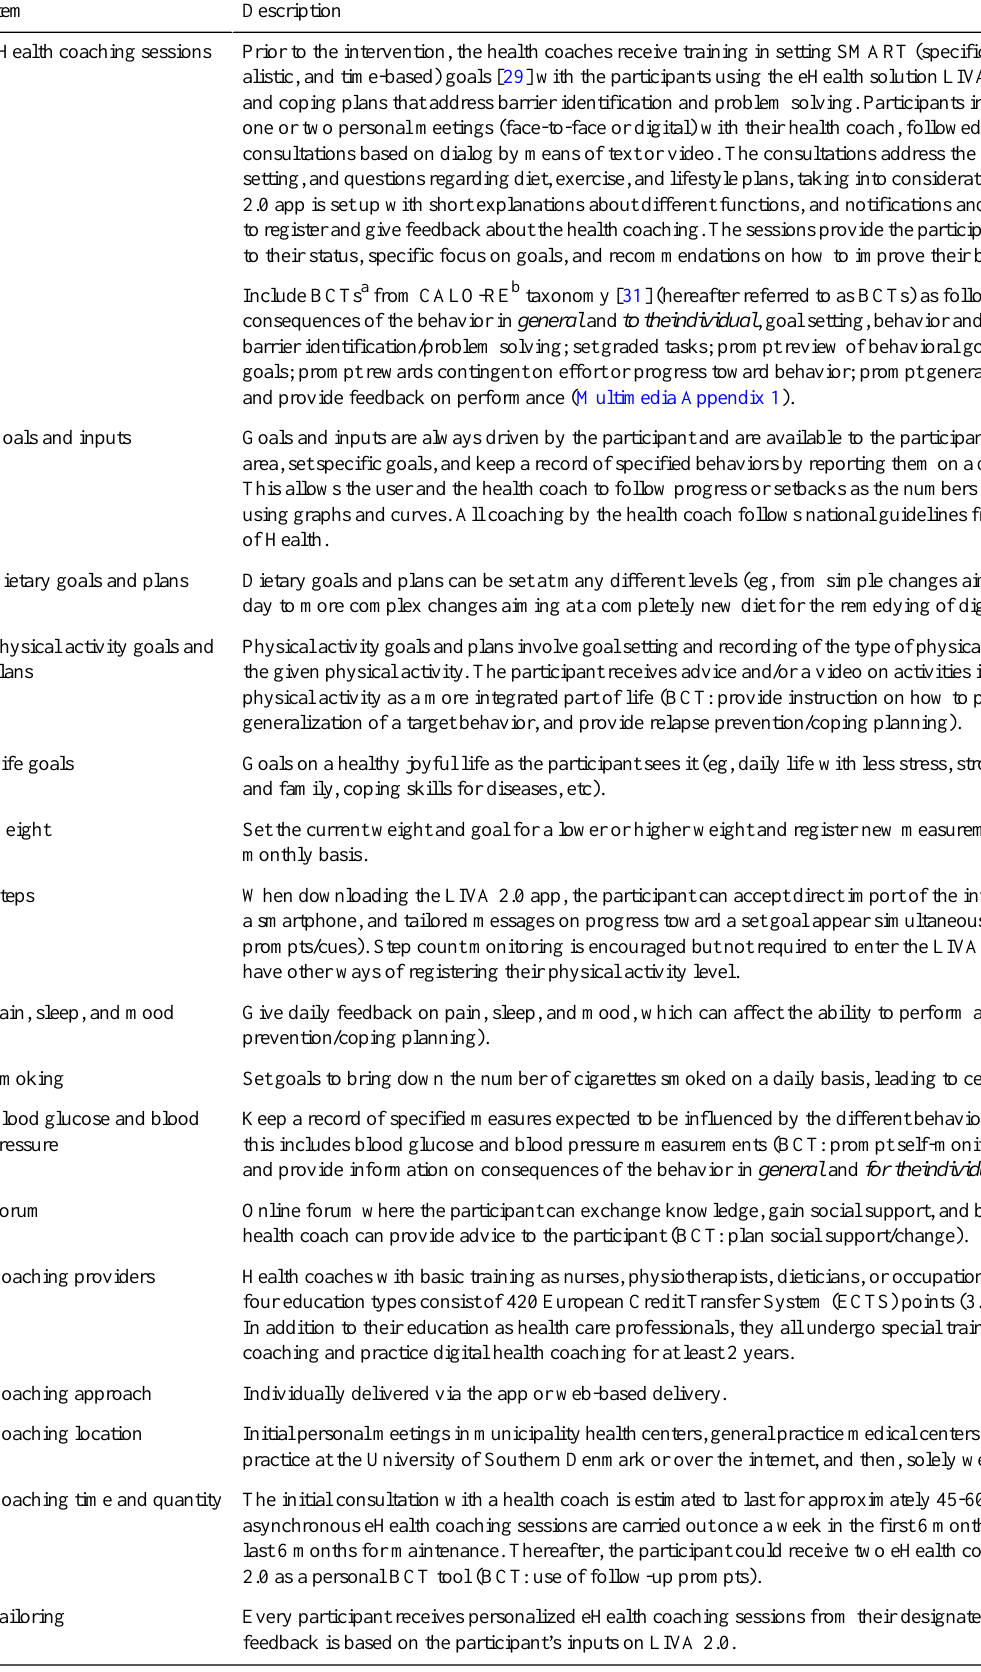
Table 1. Template of the Intervention Description and Replication checklist [30] for the eHealth lifestyle coaching tool (LIVA 2.0).